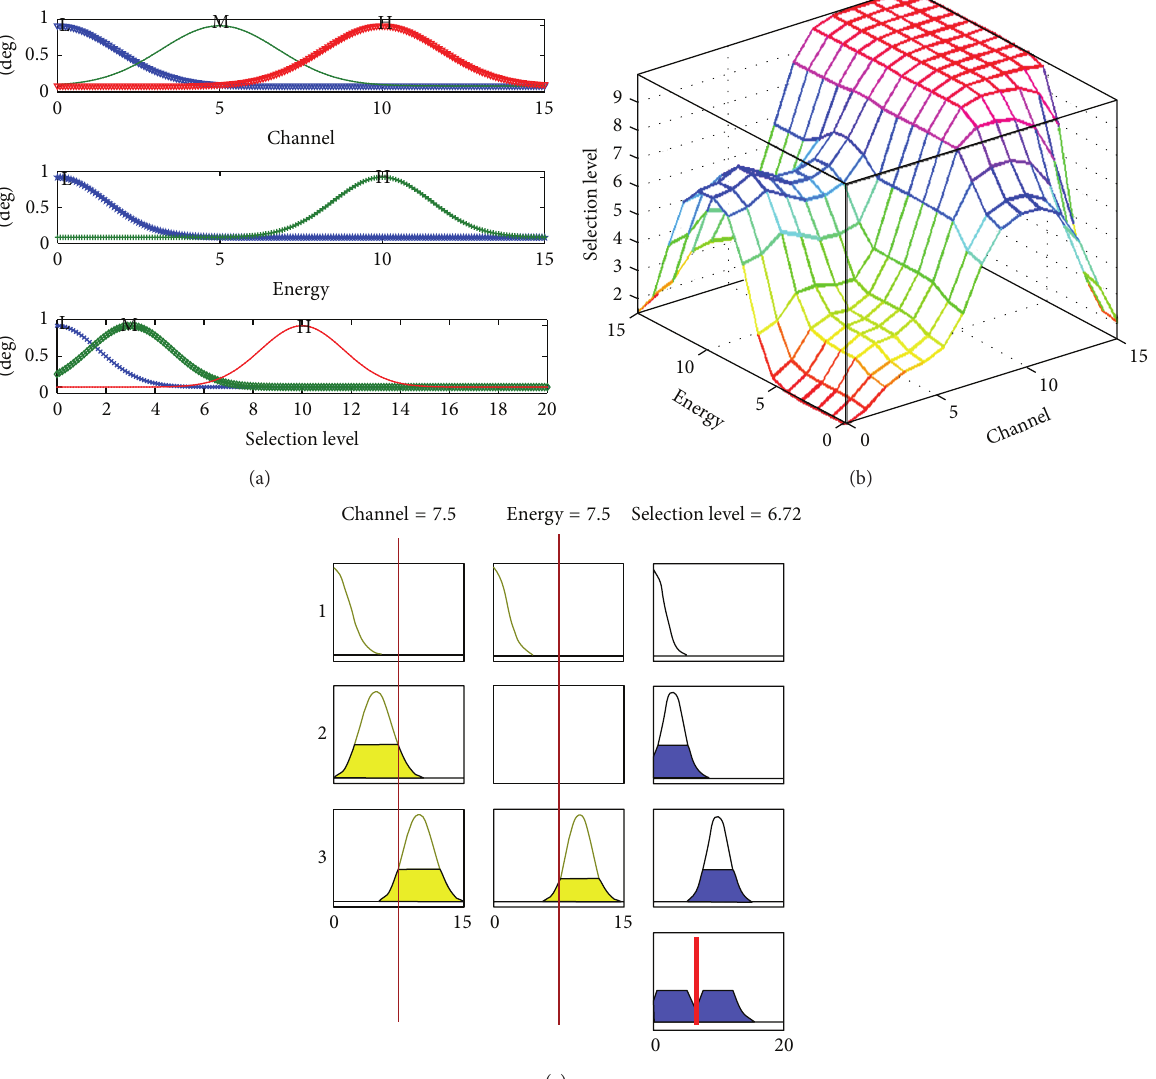
Figure 4: (a) Membership function for selection of coordinator. (b) The fuzzy inference for selection of coordinator. (c) The fuzzy inference process for selection of